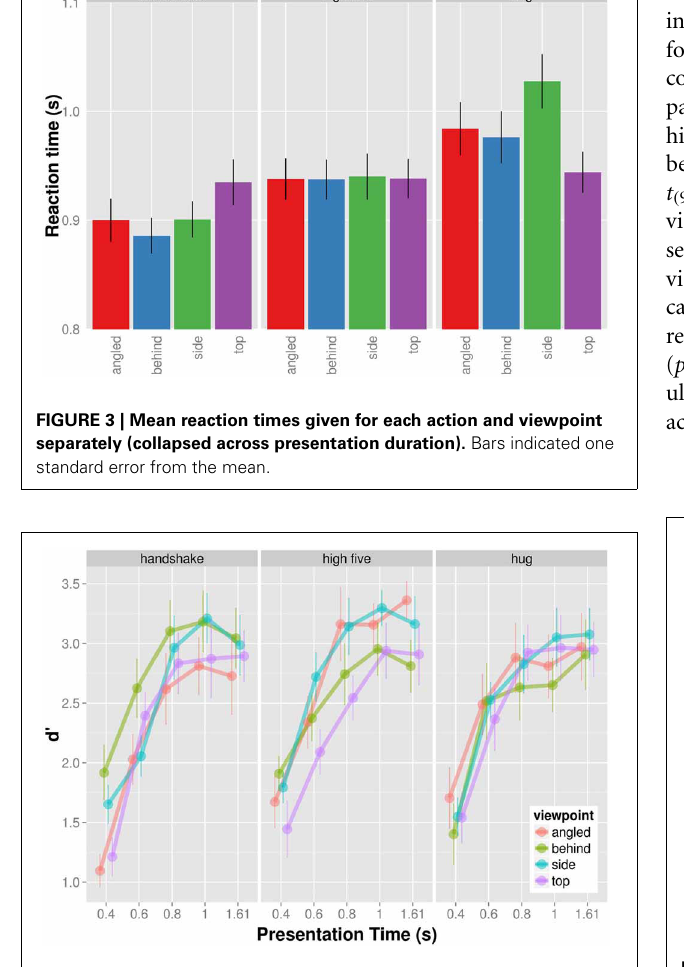
FIGURE 4 | Mean d (cid:2) as a function of presentation time shown for each action and viewpoint separately.